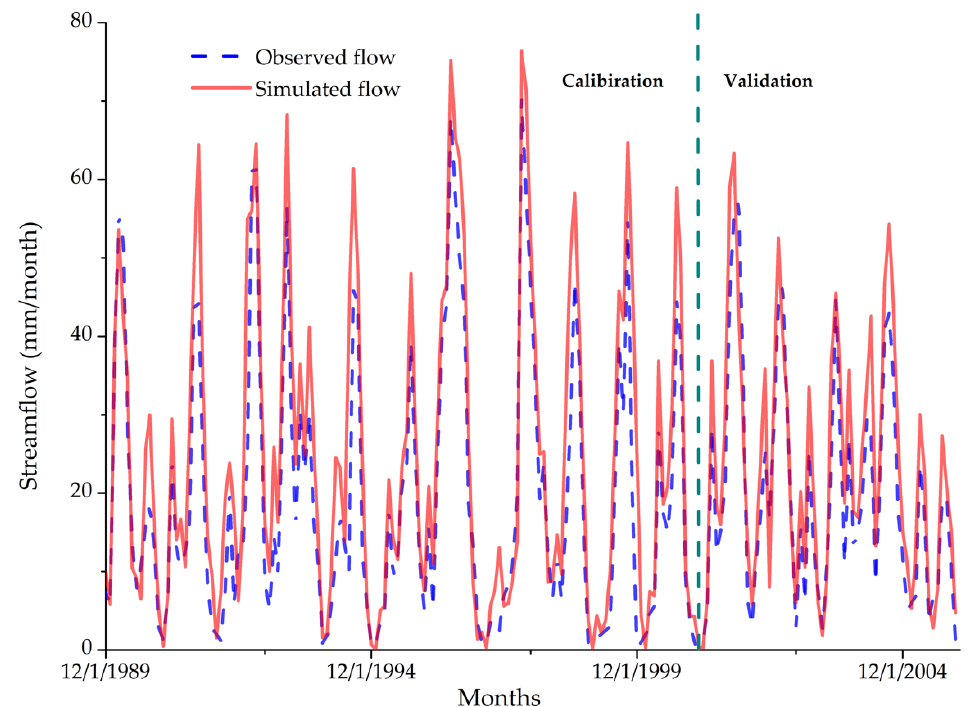
Figure 5. Comparison between simulated and observed monthly streamflow for the calibration (1989–2000) and validation (2001–2005) periods.